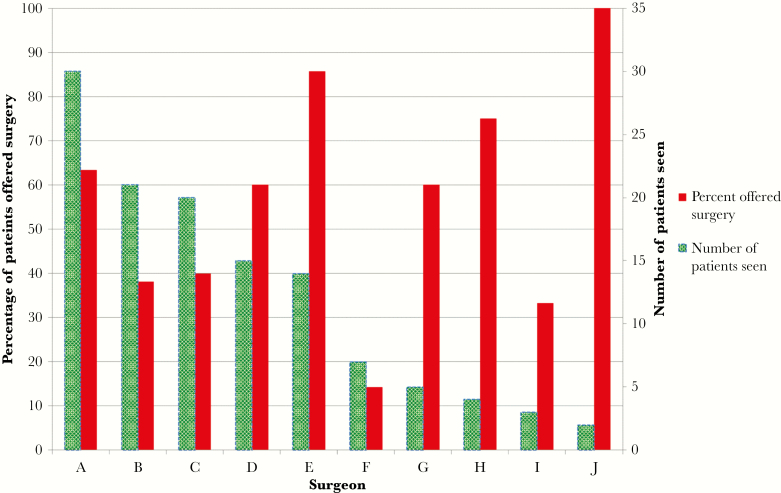
Comparison of the number of patients evaluated by each surgeon and the percentage of patients offered early surgical intervention.